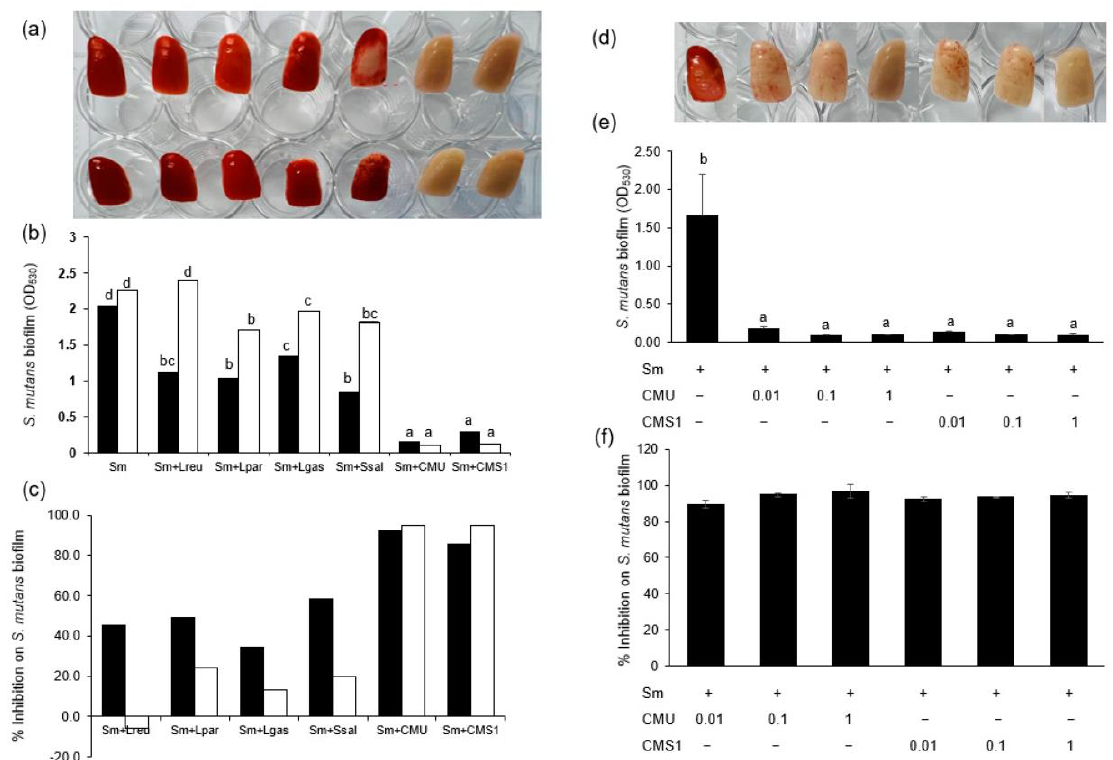
Figure 2. Effect of oral probiotics on biofilm formation by S. mutans on artificial teeth. ( a ) Effect of oral probiotics on biofilm formation compared between S. mutans KCTC 3065 (upper teeth) and S. mutans Ingbritt (lower teeth). ( b ) Comparison of S. mutans biofilm density. ( c ) Comparison of inhibition rates between oral probiotics. Equal amounts (5 × 10 6 CFU/mL) of S. mutans and oral probiotics were inoculated. Black bar, S. mutans KCTC 3065; white bar, S. mutans Ingbritt. ( d ) Dose-dependent effects of W. cibaria CMU and CMS1. ( e ) Comparison of S. mutans biofilm density according to dose- dependent effects of W. cibaria CMU and CMS1. ( f ) Dose-dependent inhibition on S. mutans biofilm formation by W. cibaria CMU and CMS1. Sm, S. mutans Ingbritt; Lreu, L. reuteri ; Lpar, L. paracasei ; Lgas, L. gasseri ; Ssal, S. salivarius ; CMU, W. cibaria CMU; CMS1, W. cibaria CMS1. Data are presented as the mean ± standard deviation. Different letters indicate significant differences at p <